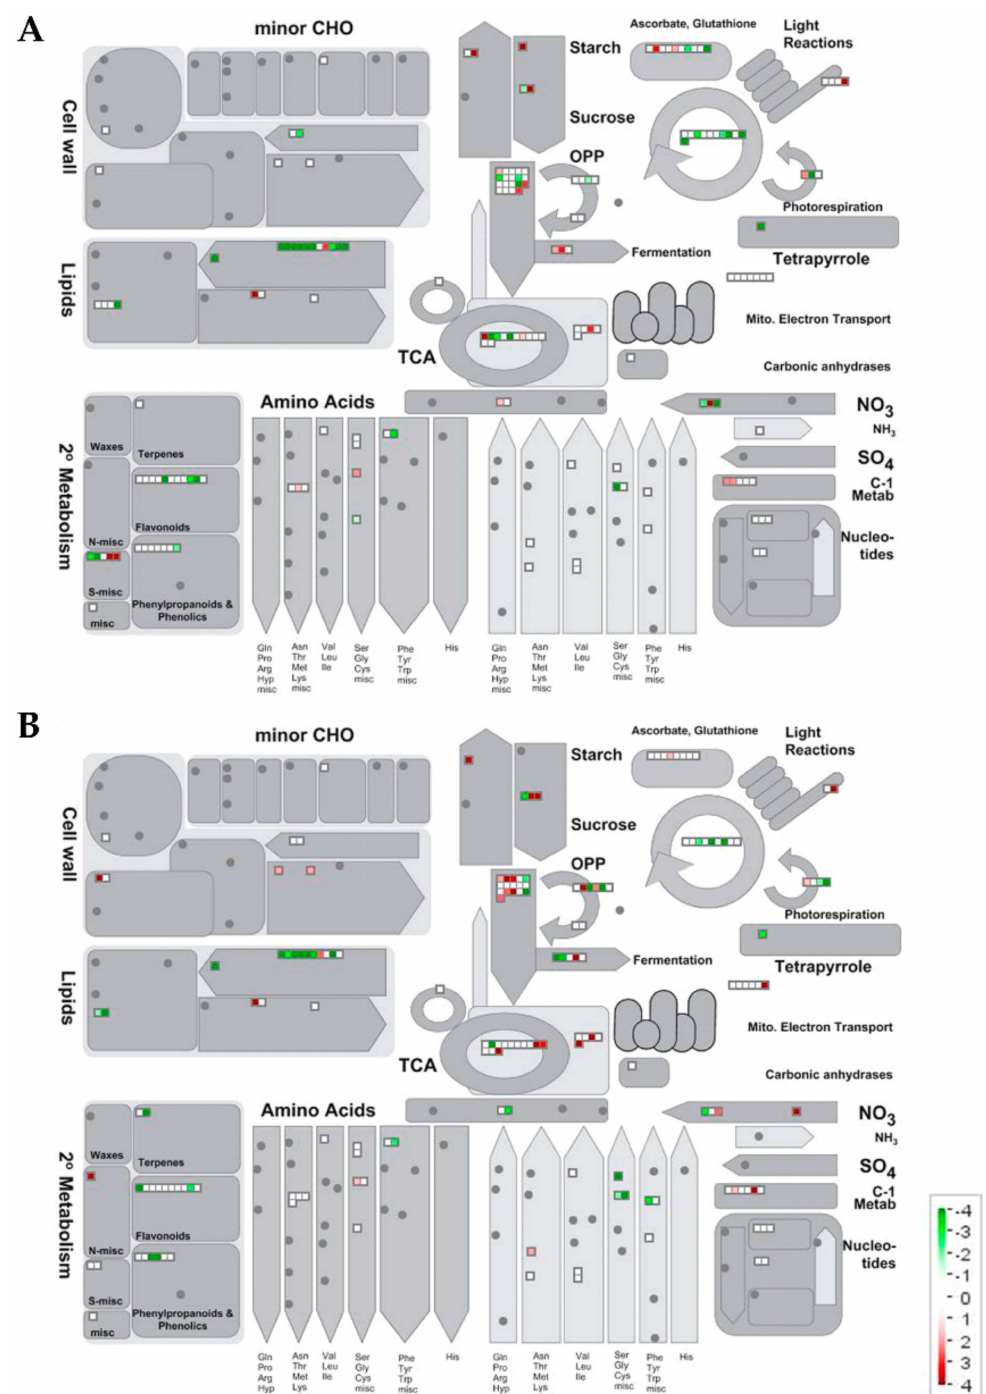
Figure 3. MapMan metabolism overview maps of the changes induced by salt stress condition. Changes in protein abundances (salt stress versus control) occurring in 101.14 ( A ) and M4 ( B ) grapevine rootstocks. Values are given in logarithmically scaled (base 1.2) signal intensities: red, increase; white, no change; green, decrease (see color